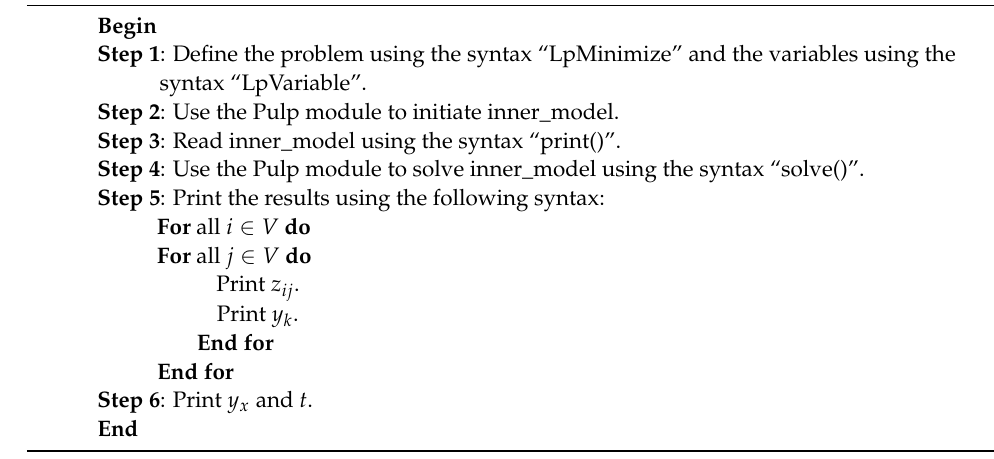
Algorithm 3: Solving inner optimization model.